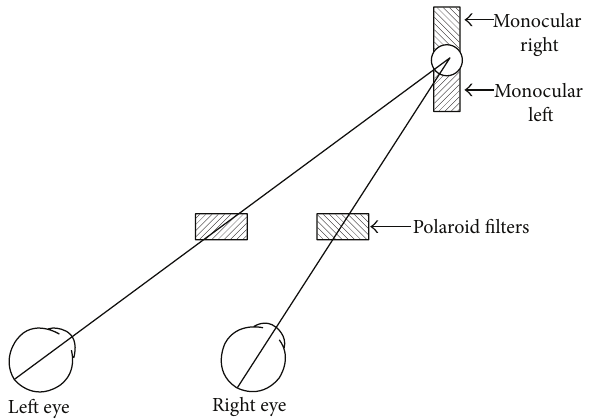
Figure 2: Appearance of the stimulus (a) within the bifixation field and (b) beyond the bifixation